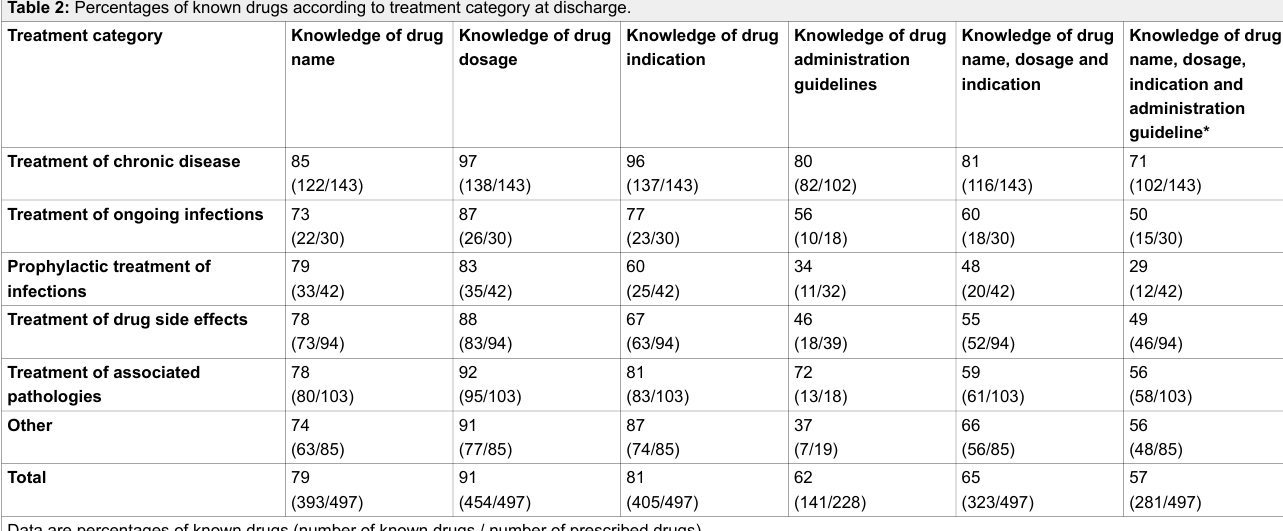
Table 2: Percentages of known drugs according to treatment category at discharge. Treatment